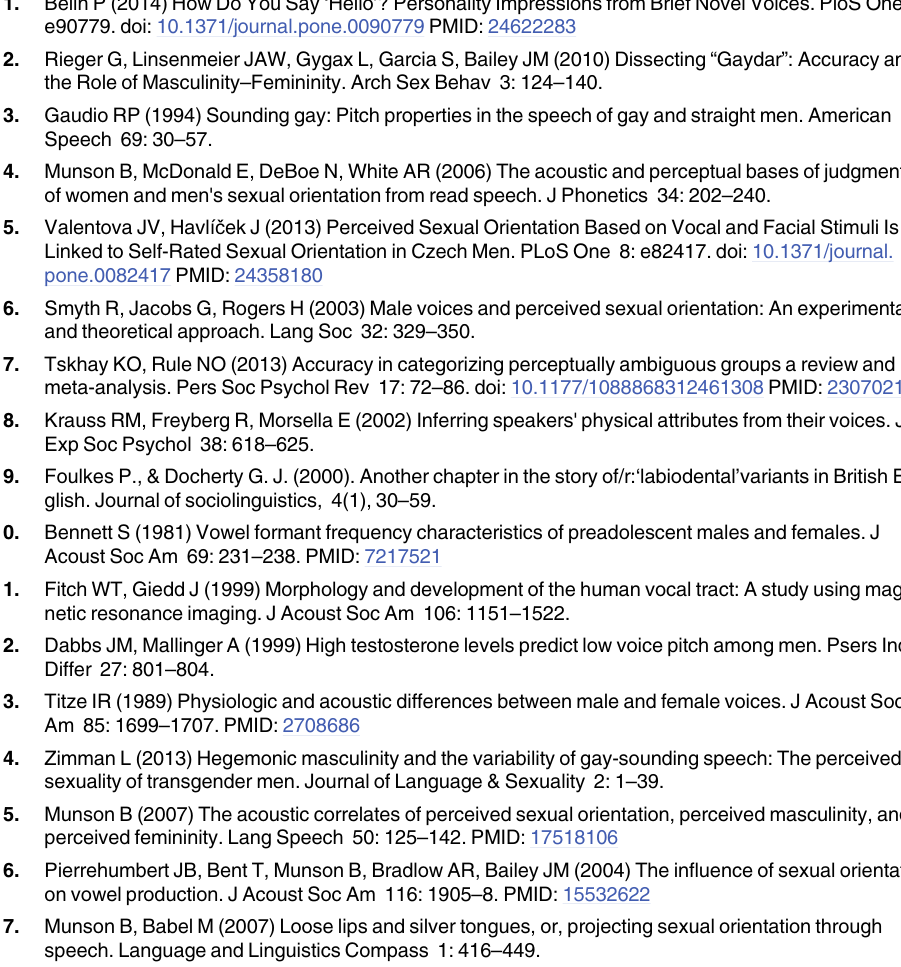
S5 Table. Statistics for each Speaker. Legend:. .1; (cid:1) < .05; (cid:1)(cid:1) < .01; (cid:1)(cid:1)(cid:1) < .001; ns: not